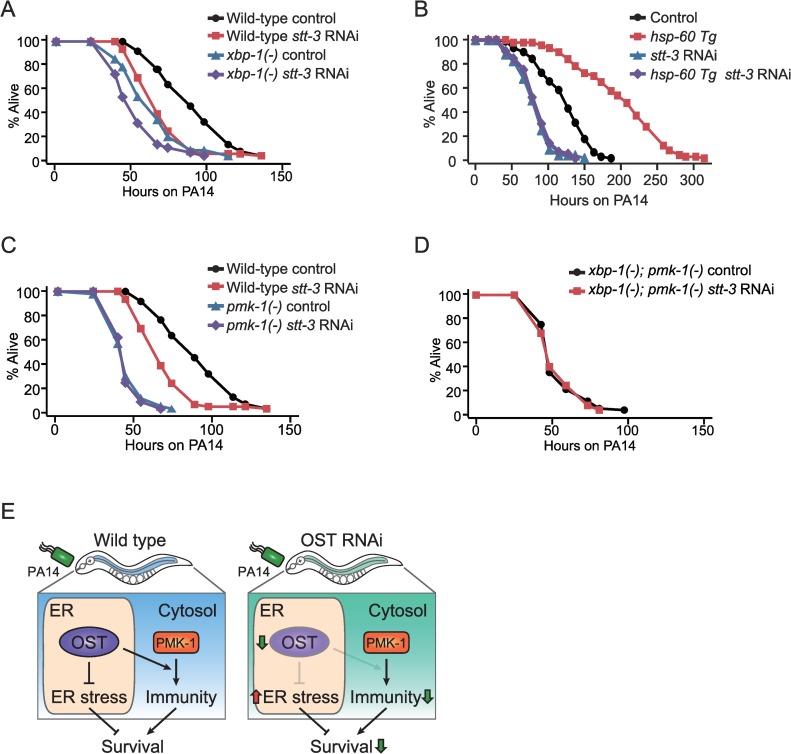
OST complex reduces susceptibility to PA14 through PMK-1 signaling.(A) Genetic inhibition of OST complex by stt-3 RNAi further decreased the survival of xbp-1(zc12) [xbp-1(-)] animals on PA14. (B-C) stt-3 RNAi suppressed the enhanced PA14 resistance of hsp-60-trangenic worms (hsp-60 Tg) (B), but did not reduce the survival of pmk-1(km25) [pmk-1(-)] mutants (C) upon PA14 infection. (D) stt-3 RNAi did not affect the PA14 susceptibility of xbp-1(-); pmk-1(-) animals. We also obtained data suggesting that VIT-6 affects sensitivity to PA14 independently of HSP-60 and PMK-1 pathway (See S7 Fig. legends for details). (E) Schematic model. OST contributes to the maintenance of worm survival on PA14 infection by decreasing stress in the ER and by up-regulating PMK-1-mediated immunity in the cytosol. See S3 Table for additional repeats and statistical analysis for survival assay results in this figure.